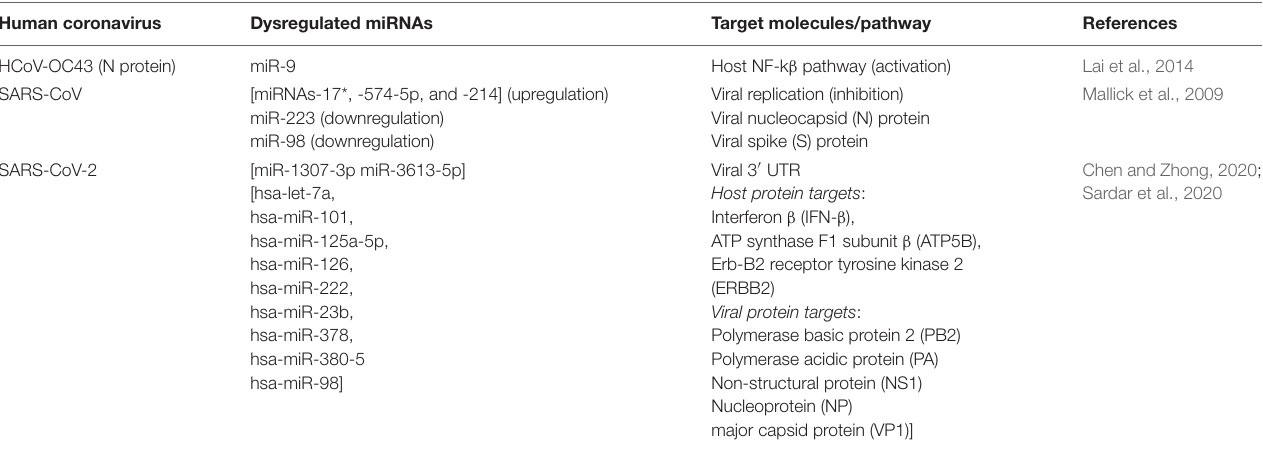
TABLE 1 | List of important miRNAs involved in some HCoV